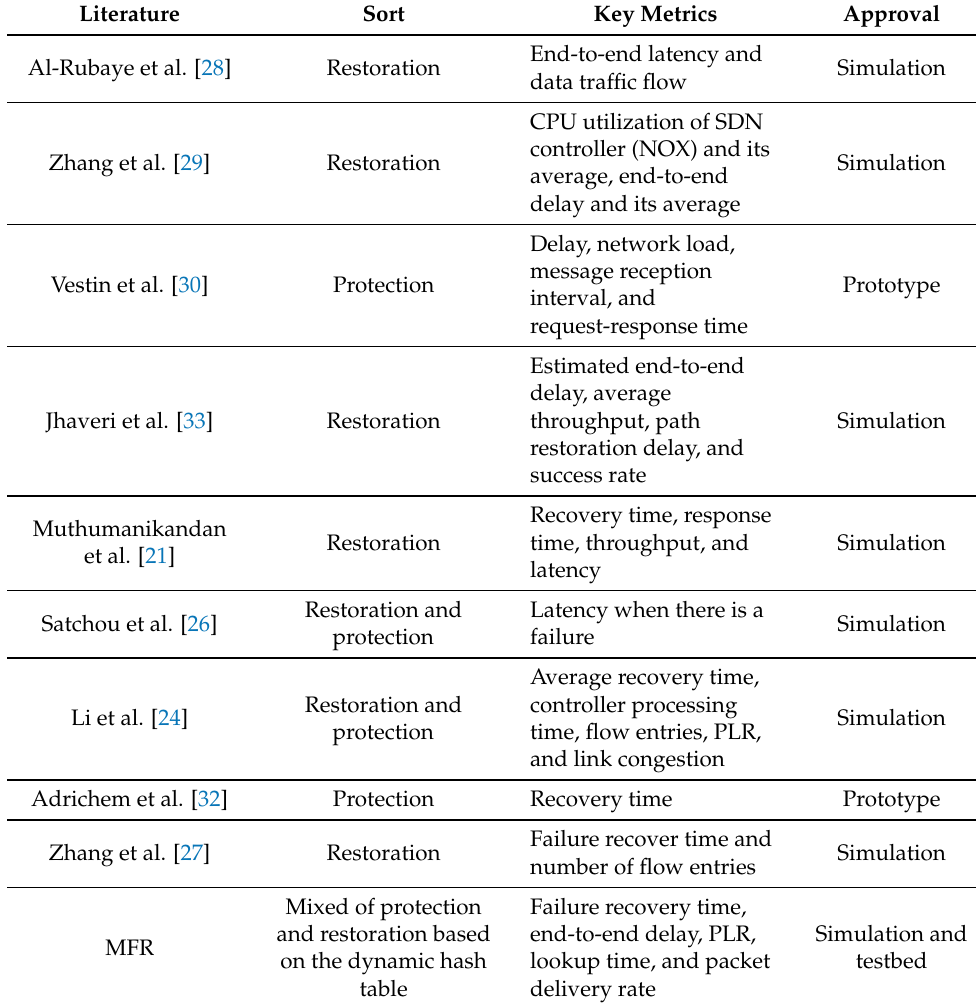
Table 1. A comparison of related studies with regards to the sort of resilience (protection, restoration or both), key metric, and approval